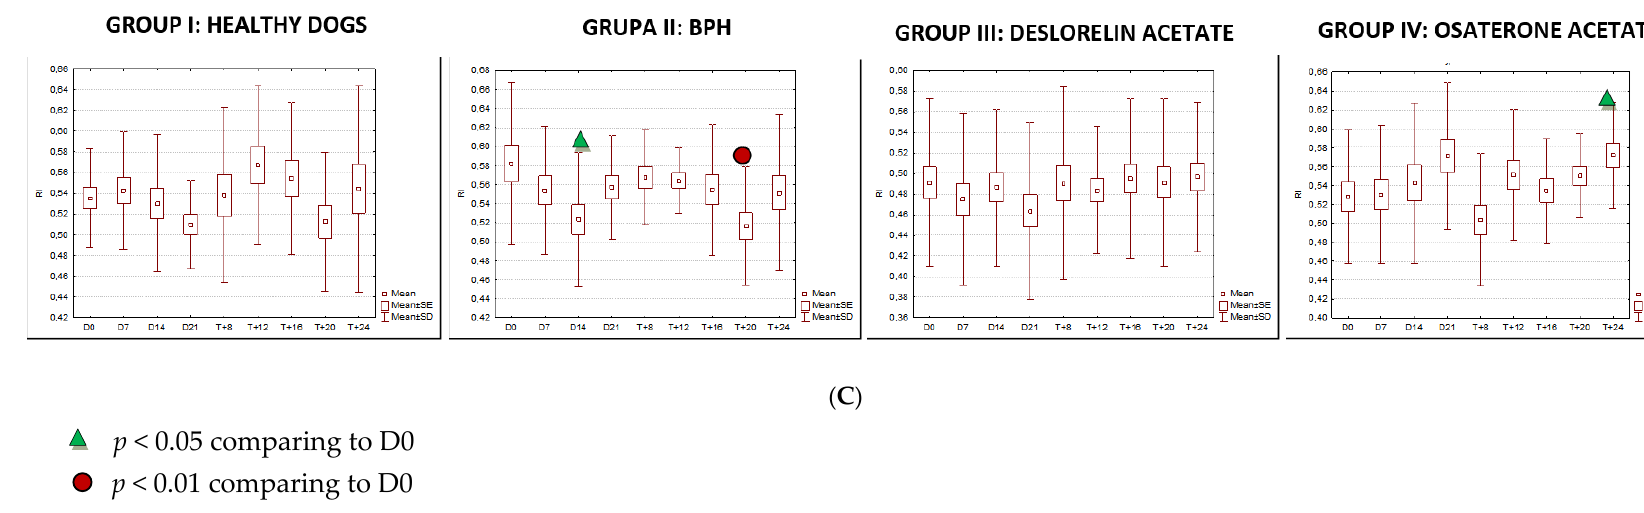
p < 0.05 comparing to D0